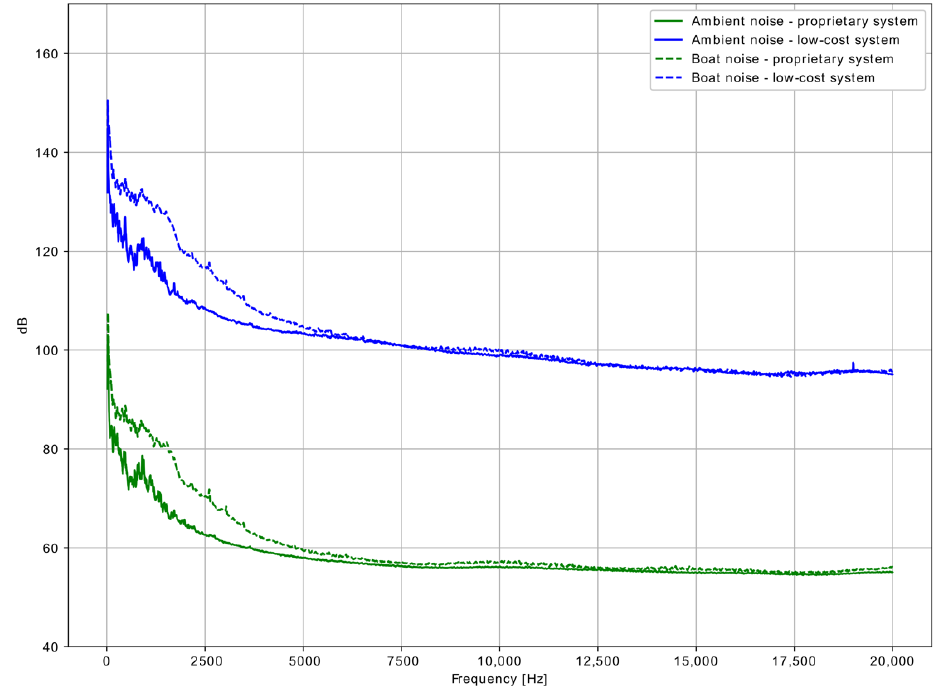
Figure 8. Comparison of spectra obtained from the reference proprietary system (green) and the low-cost system (blue) in the case of ambient noise (solid line) and a known noise source: a boat (dashed line); the difference in gain is due to the difficulties in controlling the gain of the low-cost sound interface.